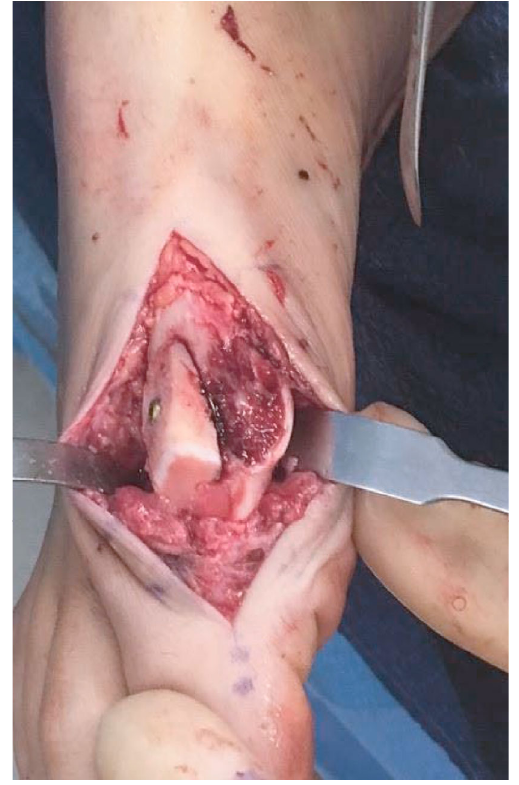
Figure 5: Fresh talonavicular joint cartilage implant increased dorsi fl exion and plantar fl exion by 20 degrees during the